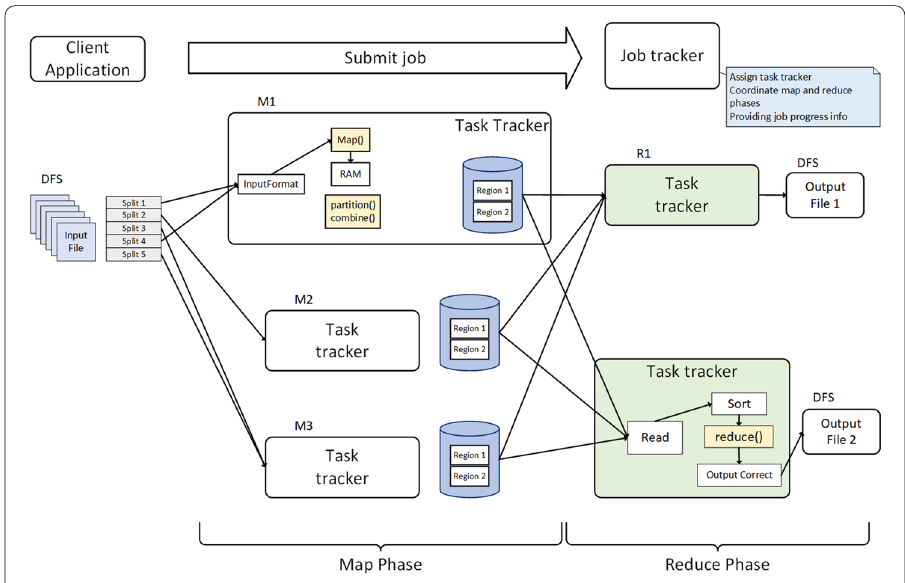
Fig. 2 System structure nd operation flow of